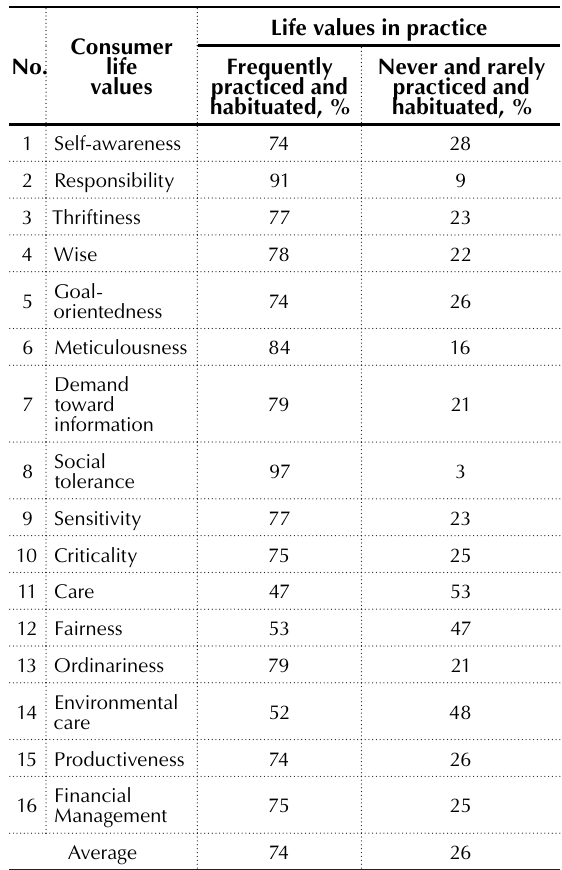
Table 4. Practices of life values in Consumer Education